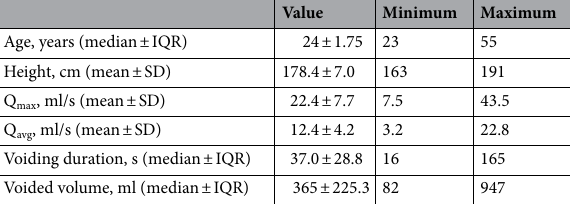
Table 1. Descriptive and demographic parameters. SD standard deviation, IQR inter-quartile range.